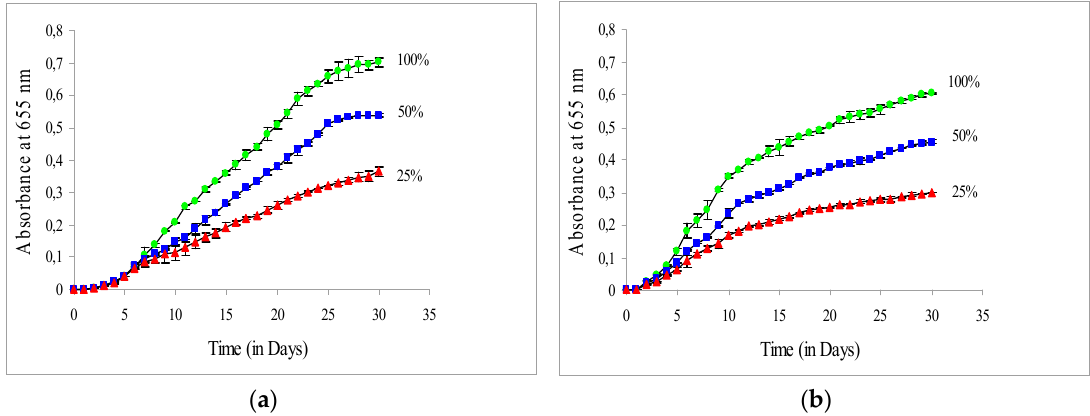
Figure 1. Growth curves of C. vulgaris cultivated during June ( a ) and September ( b ) in the greenhouse at 100%, 50%, and 25% of solar irradiance. The error bars represent the standard deviation of the means. Table 1. Specific growth rates ( μ exp ) in the exponential growth phase (in d − 1 ) and biomass (P b ), lipid (P l ), and protein (P p ) productivities (in g L − 1 d − 1 ) of C. vulgaris cultivated during June and September in the greenhouse at 100%, 50% and 25% of solar irradiance.